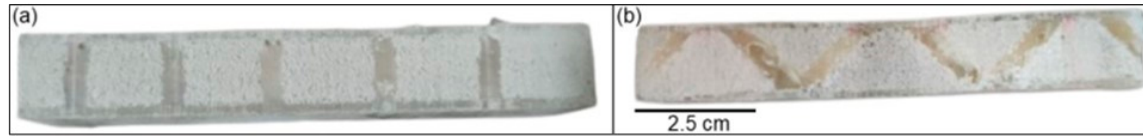
Figure 8. Sandwich panels’ cross section ( a ) 0HD and ( b ) AHD.